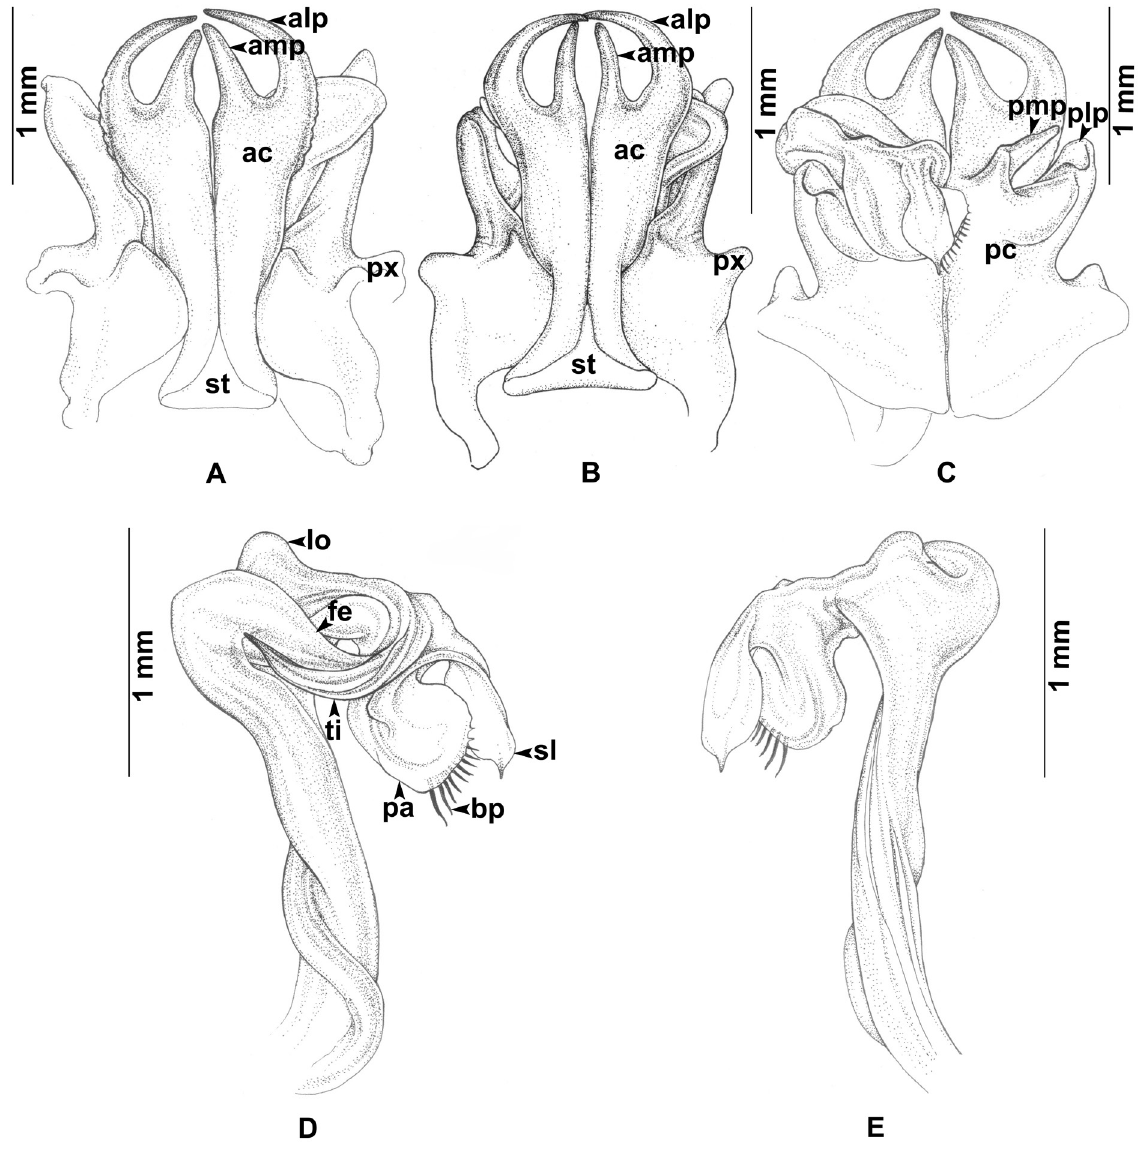
Fig. 4. Thyropygus forceps sp. nov., gonopods. – A , C – E . Holotype (CUMZ-D00092), ♂, from Namwang Srithammasokrach. A. Anterior view, left telopodite removed. C. Posterior view, left telopodite removed. D. Left telopodite, posterior-mesal view. E. Left telopodite, anterior-lateral view. – B . Specimen from Tham Pha Deang temple (CUMZ-D00093), ♂. Anterior view, left telopodite